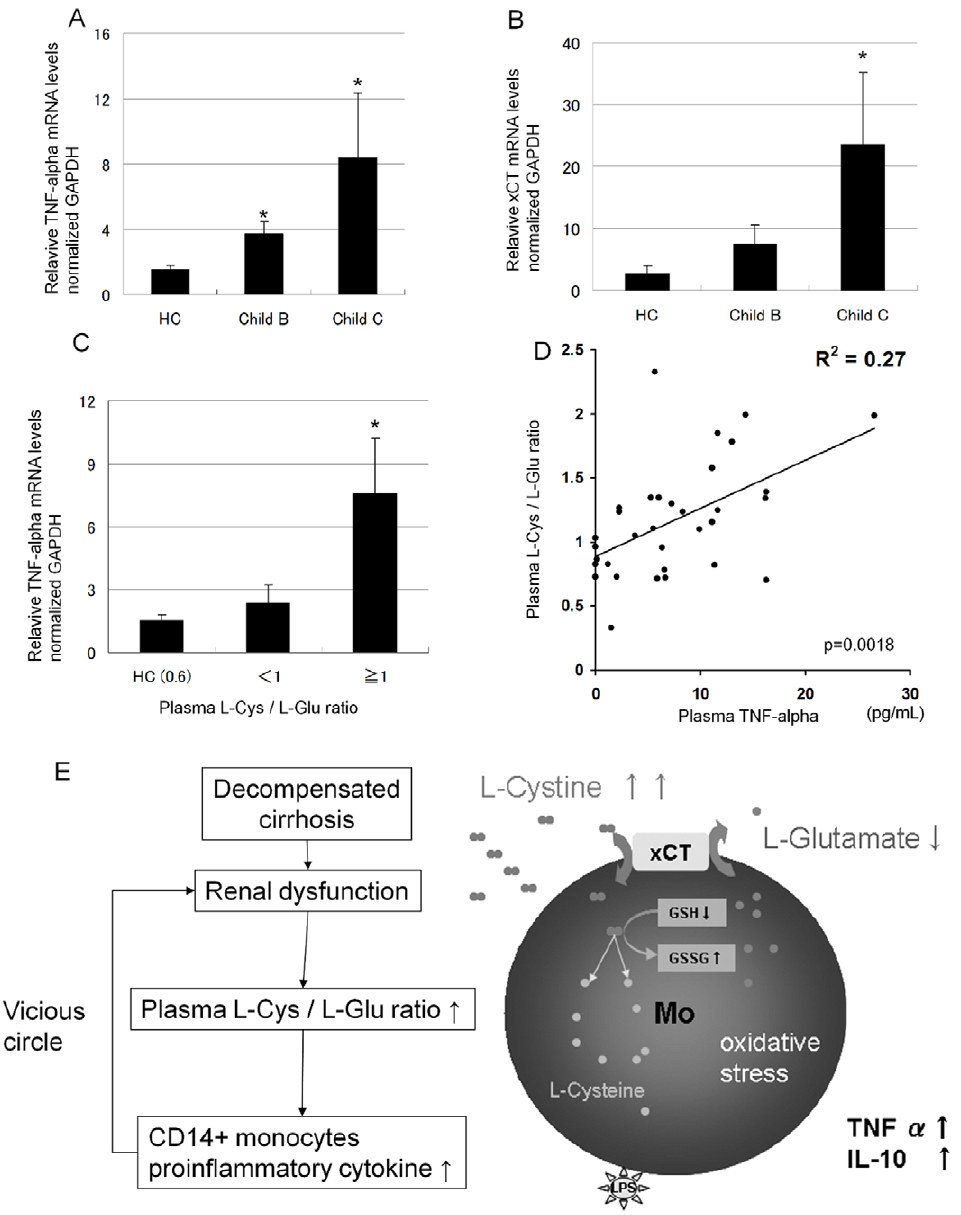
Figure 4. The plasma L-Cys/L-Glu ratio significantly correlated with the plasma TNF-alpha level in patients with advanced cirrhosis. A, CD14 + monocytes were isolated from healthy volunteers (n=5) and patients with adcanced cirrhosis (Table S2 : Patient 1–19). the TNF-alpha relative mRNA levels of CD14 + monocytes were determined by real time PCR : delta-delta CT method. All mRNA expression levels were normalized to GAPDH. B, Similarly as in Fig. 4A, the xCT relative mRNA levels of monocytes were determined by real time PCR. C, These patients were separated into a high L-Cys/L-Glu ratio group ( $ 1) and low ratio group ( , 1). In healthy control (HC), the average plasma L-Cys/L-Glu ratio was 0.61 6 0.21. D, Linear regression model was used to model variation in plasma L-Cys/L-Glu ratio and plasma TNF-alpha. R 2 represents coefficient of determination. E, The schematic diagram of the present study concerning monocytes abnormality in patients with decompensated cirrhosis. A,B,C *, p , 0.05 vs HC (the Mann-Whitney